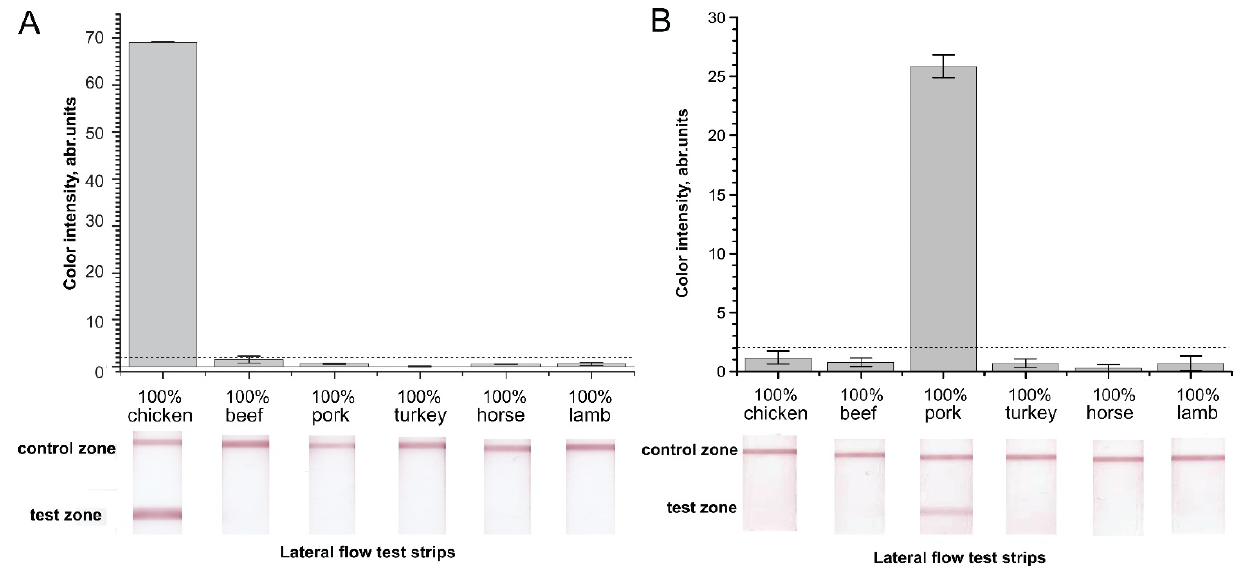
Figure 3. Specificity of RPA–LFA with the selected primers for total DNA extracted from meats of different origin. Color intensities of the test zone and corresponding scans of the test strips after developing the RPA–LFA. ( A ). RPA–LFA for chicken meat detection, ( B ). RPA–LFA for pork detection. The dashed line represents the signal visible to the naked eye (2 a.u.).